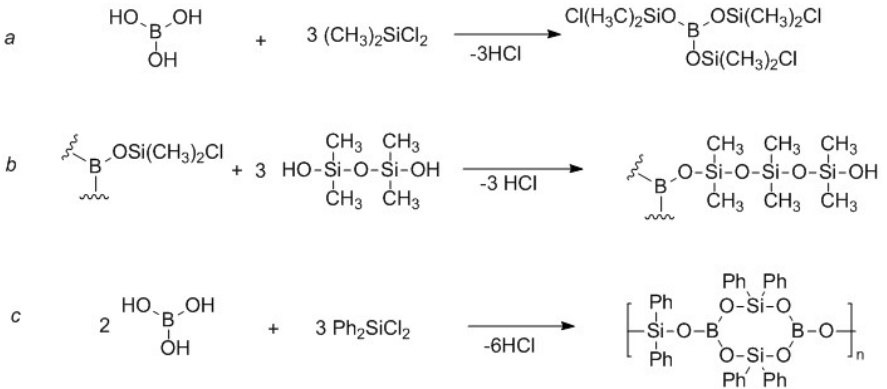
Scheme 4. Directed synthesis of PBS with various structures: synthesis of trifunctional borosiloxane with chlorosilyl groups (a); its reaction with disiloxane disilanol (b) and preparation of cyclolinear PBS from boric acid and